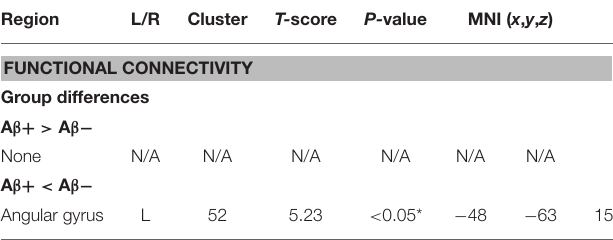
TABLE 2 | Group comparison by voxel-wise